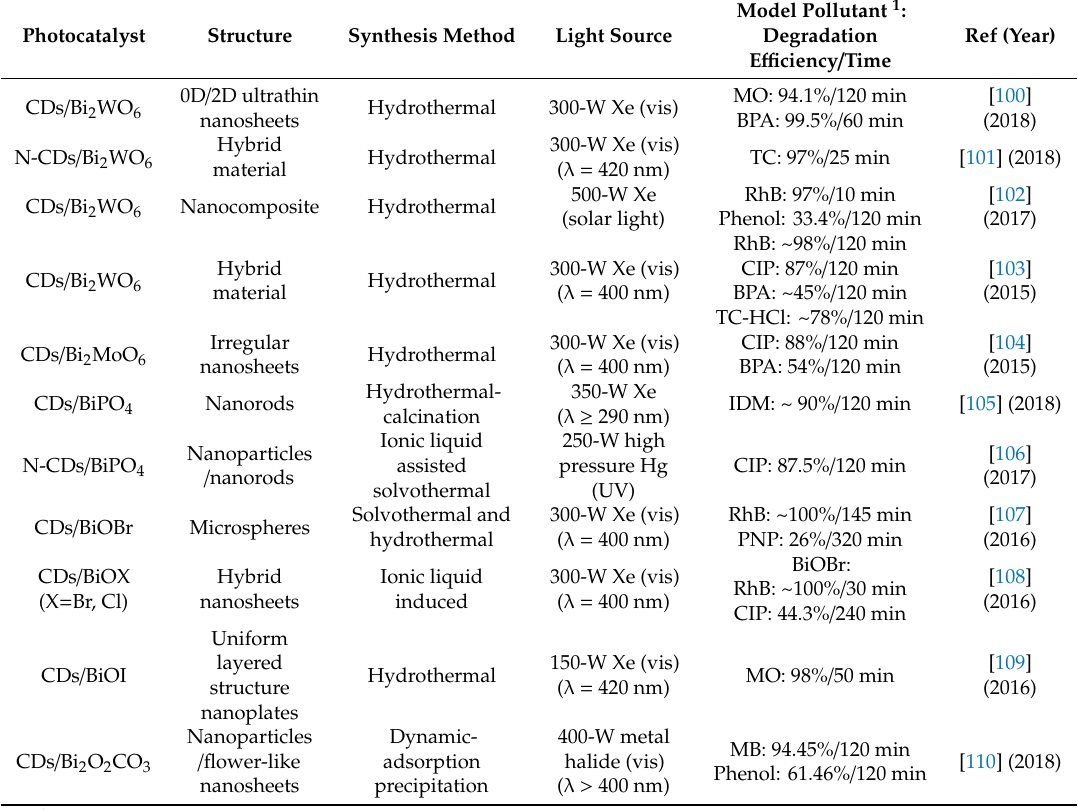
Table 7. Photodegradation e ffi ciency of CDs / Bi